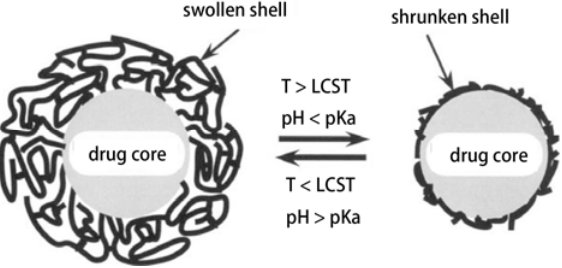
Figure 18. Schematic diagram showing ideal particle structure of drug carriers with temperature- and pH-responsive shells